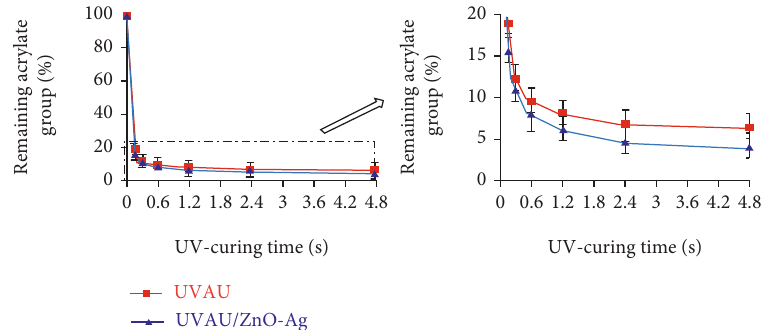
Figure 5: Conversion of the acrylate groups under the UV light irradiation.